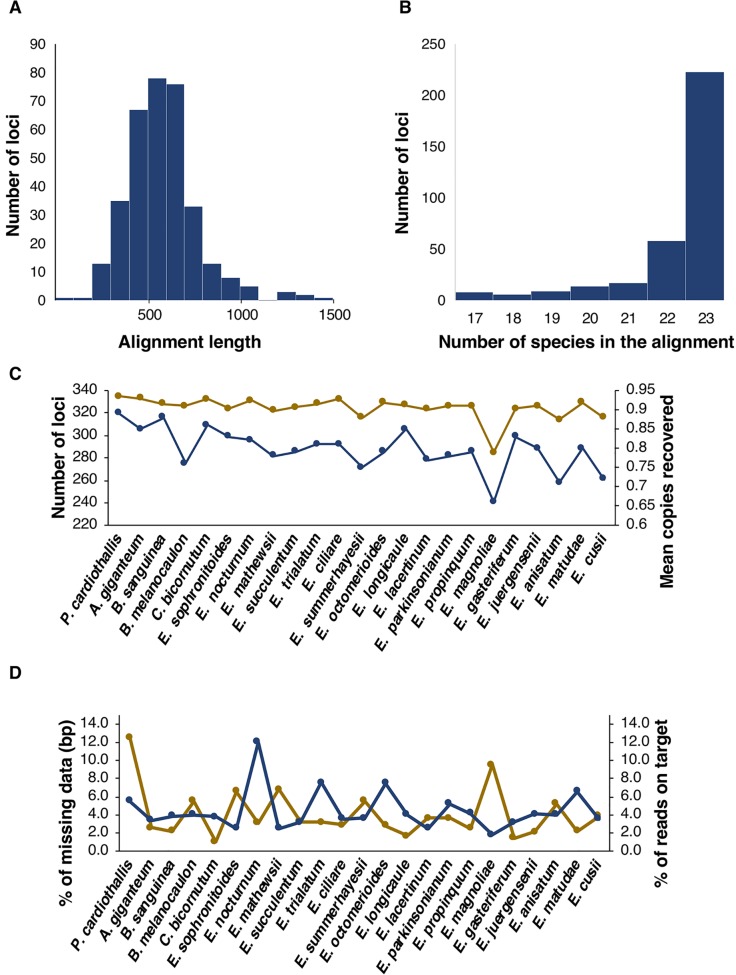
Attributes of retrieved nuclear loci. (A, B) Histograms showing length and number of species in the alignments, respectively. (C) Number of loci (yellow points and lines) and mean copies recovered (blue points and lines) per species. (D) % of missing data per species, including bases called as N plus missing flanking regions of loci, in terms of number of base pairs (bp, yellow points and lines) and % of reads on target per species (blue points and lines).